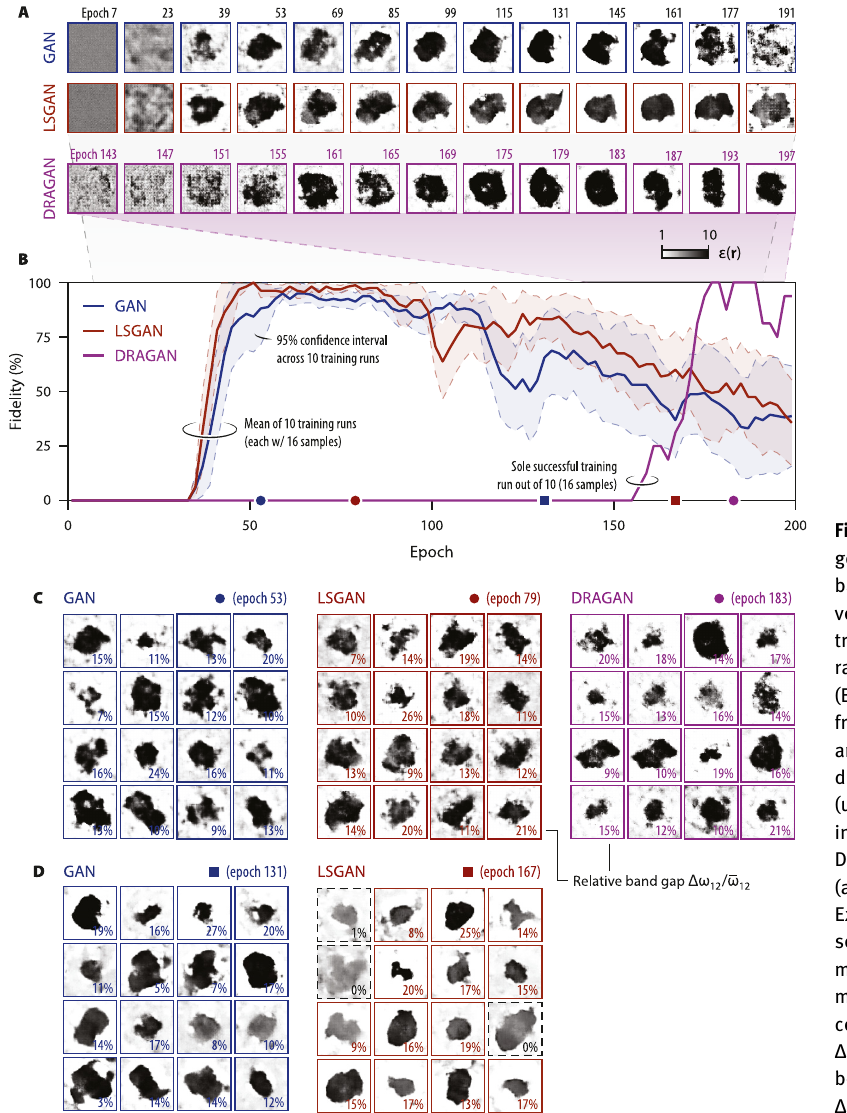
Figure 4: GAN, LSGAN, and DRAGAN for generationof unit cells with substantialTM bandgaps.(A)Themappingoffixedfeature vectors to generated unit cells during training.Notethedifferingepochstepsand rangesforDRAGANversusGANandLSGAN. (B) Fidelity of generated unit cells (the fraction hosting a band gap ≥ 5%). For GAN and LSGAN, fidelity is averaged over 16 distinctfeaturevectorsand10trainingruns (uncertainty across training runs is indicatedbyshadedregions).Onlya single DRAGAN training run was successful (averaged over 16 outputs). (C – D) Examples of generated unit cells at selected epochs (indicated by matching markers in B). GAN and LSGAN produce more well-defined but lower-fidelity unit cells at later epochs (text-insets give Δ ω / ¯ ω 12 12 evaluated with MPB; dashed borders highlight cases where Δ ω / ¯ ω < 12 12